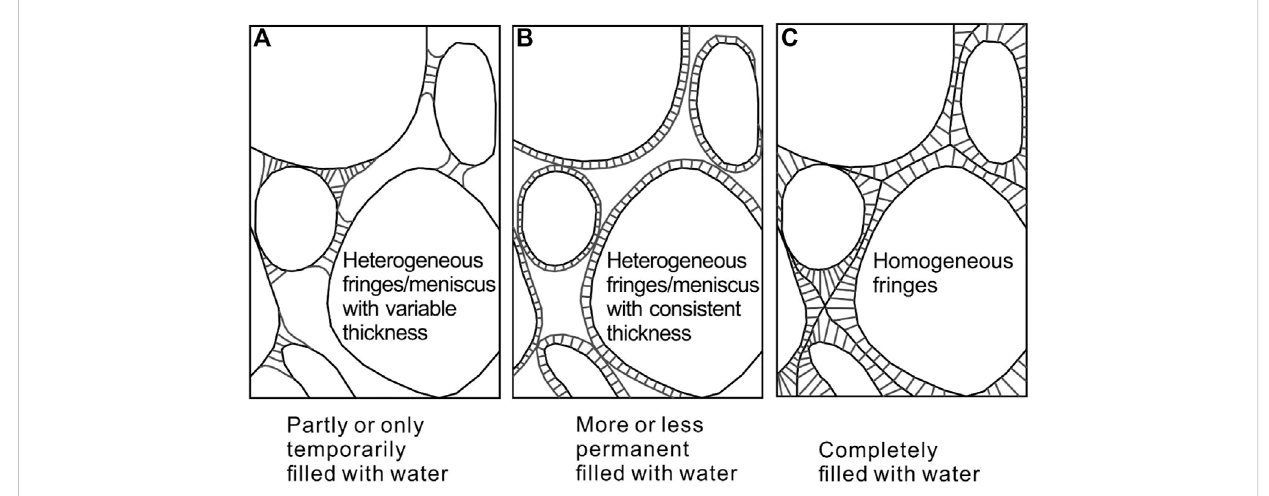
FIGURE 3 Distribution of cement under various environments. Revised from Scholle and Ulmer-Scholle,